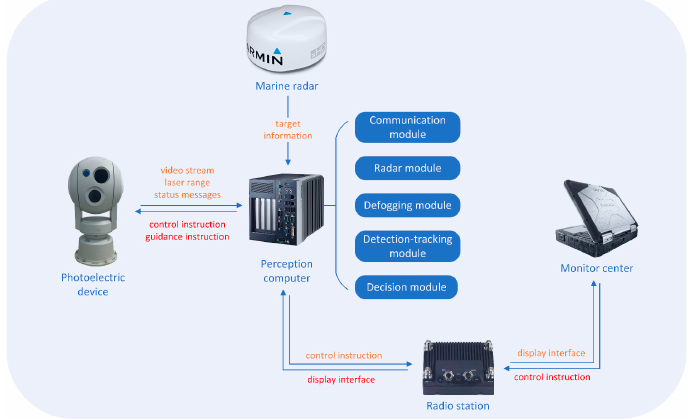
Figure 3. Information transfer diagram of the USV perception system.